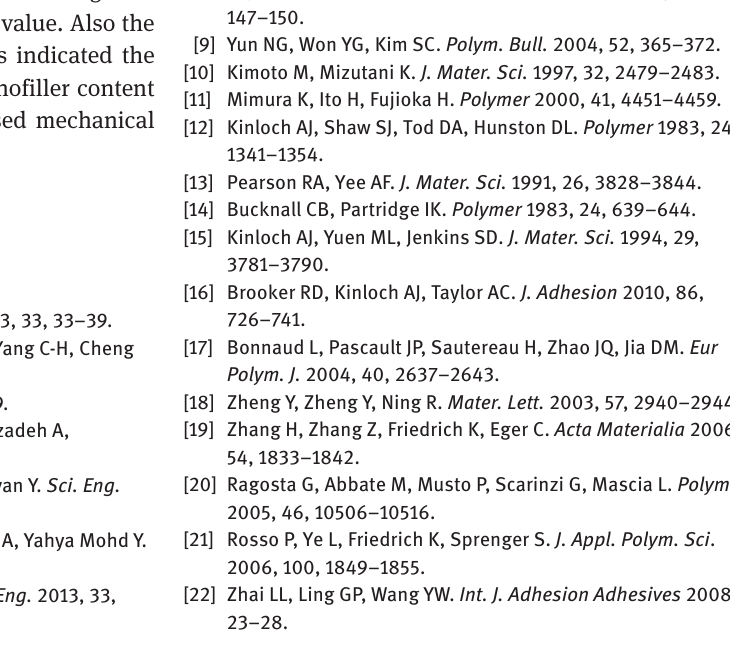
Figure 5: Scanning electron micrographs of a fracture surface for samples (A) neat, having (B) 3.5 w% SiO MWCNT and (E) 1 w%